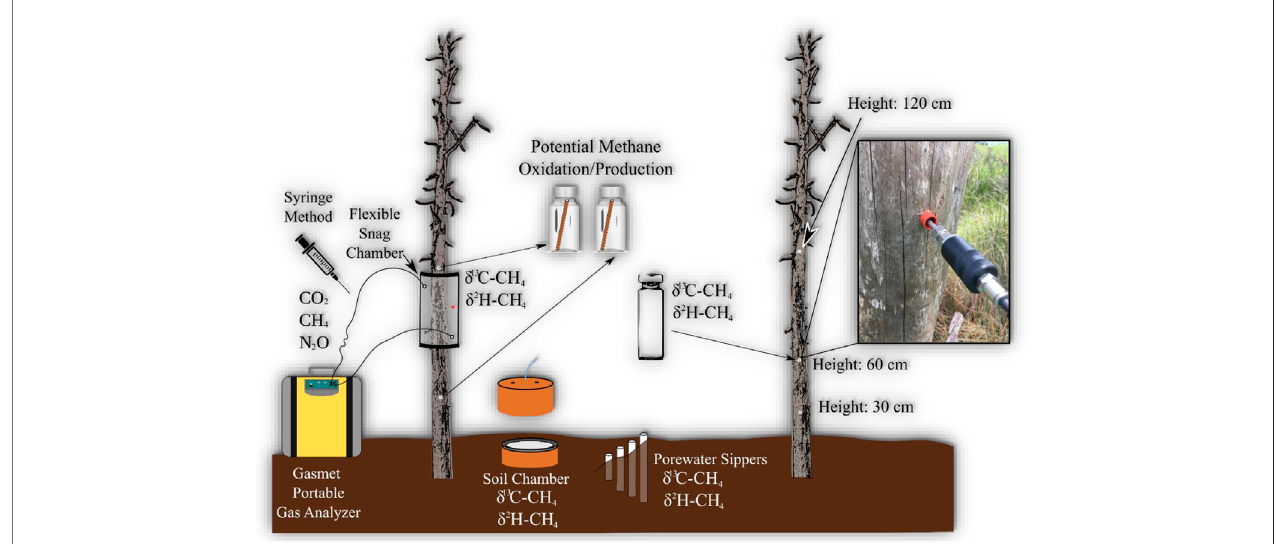
FIGURE1| Conceptualdiagramofmonitoringsetupforeachsite.Gassamplesweretakenfromsnagandsoilgreenhousegaschambers,andwatersamplesfrom porewaterfordissolvedCH 4 concentrations.Reddotontreechamberisrubberseptumwhichisusedwhenextractingsampleswithsyringe.Snagsweredrilledatthree heights to measure CH 4 concentrations within heartwood of snag. Tree cores were also taken from two heights (60 and 120 cm) for lab incubation experiments to measure potential CH 4 production and